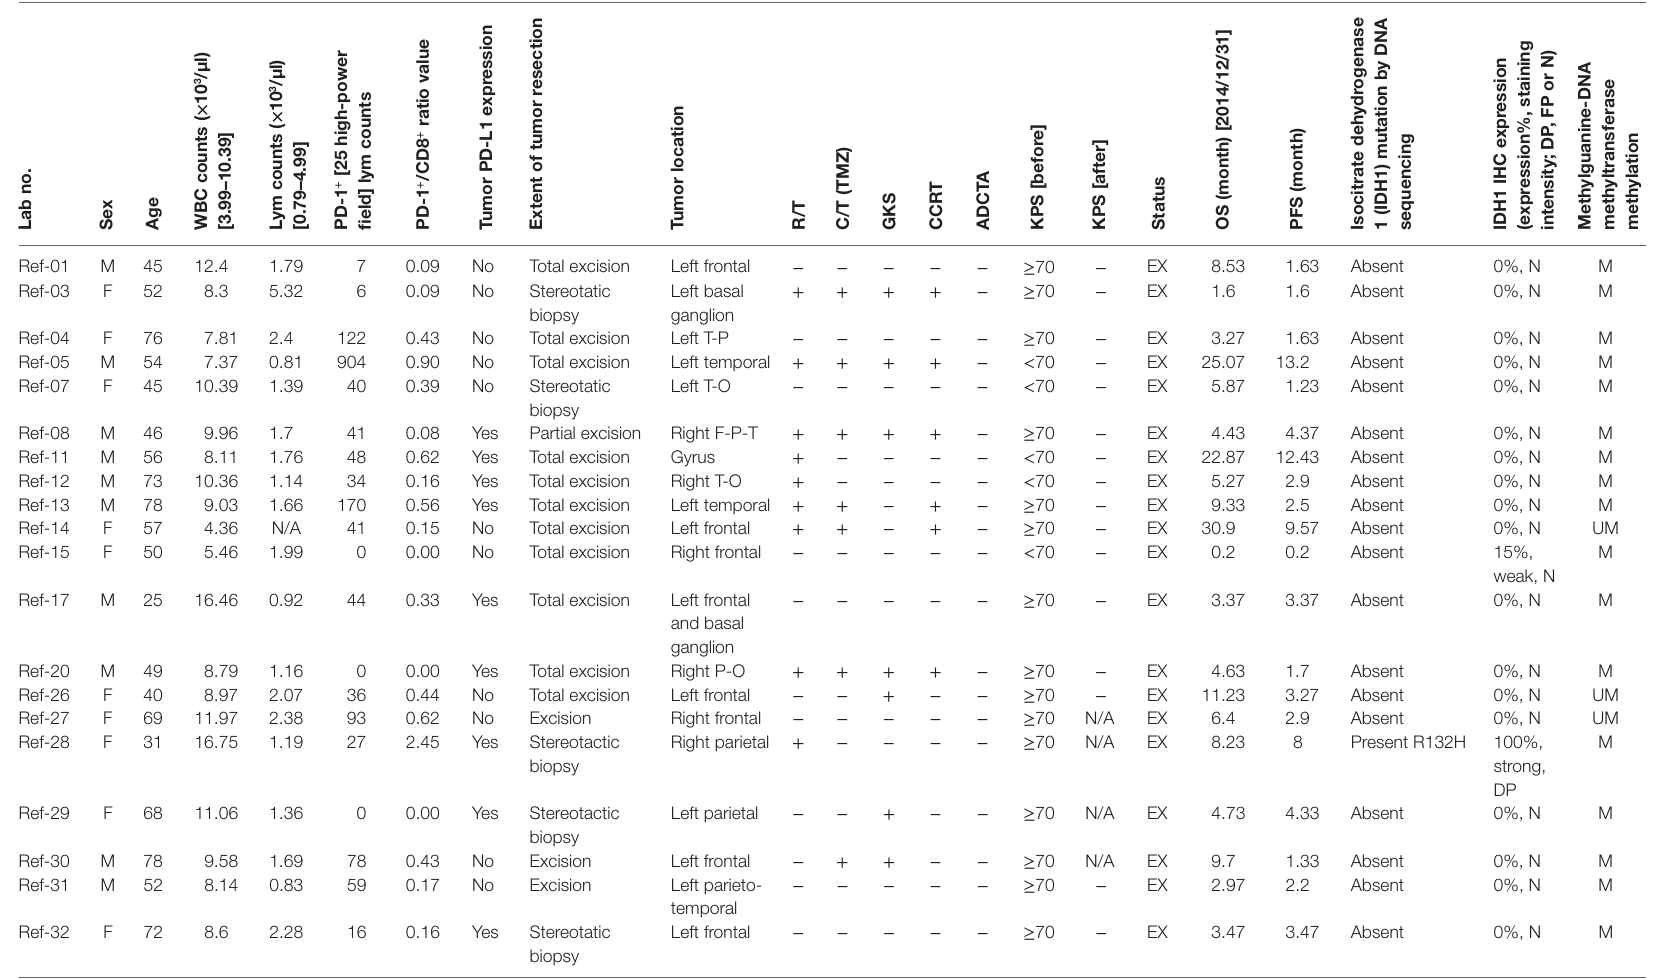
TaBle 3 | Summary of patient data in the reference group.